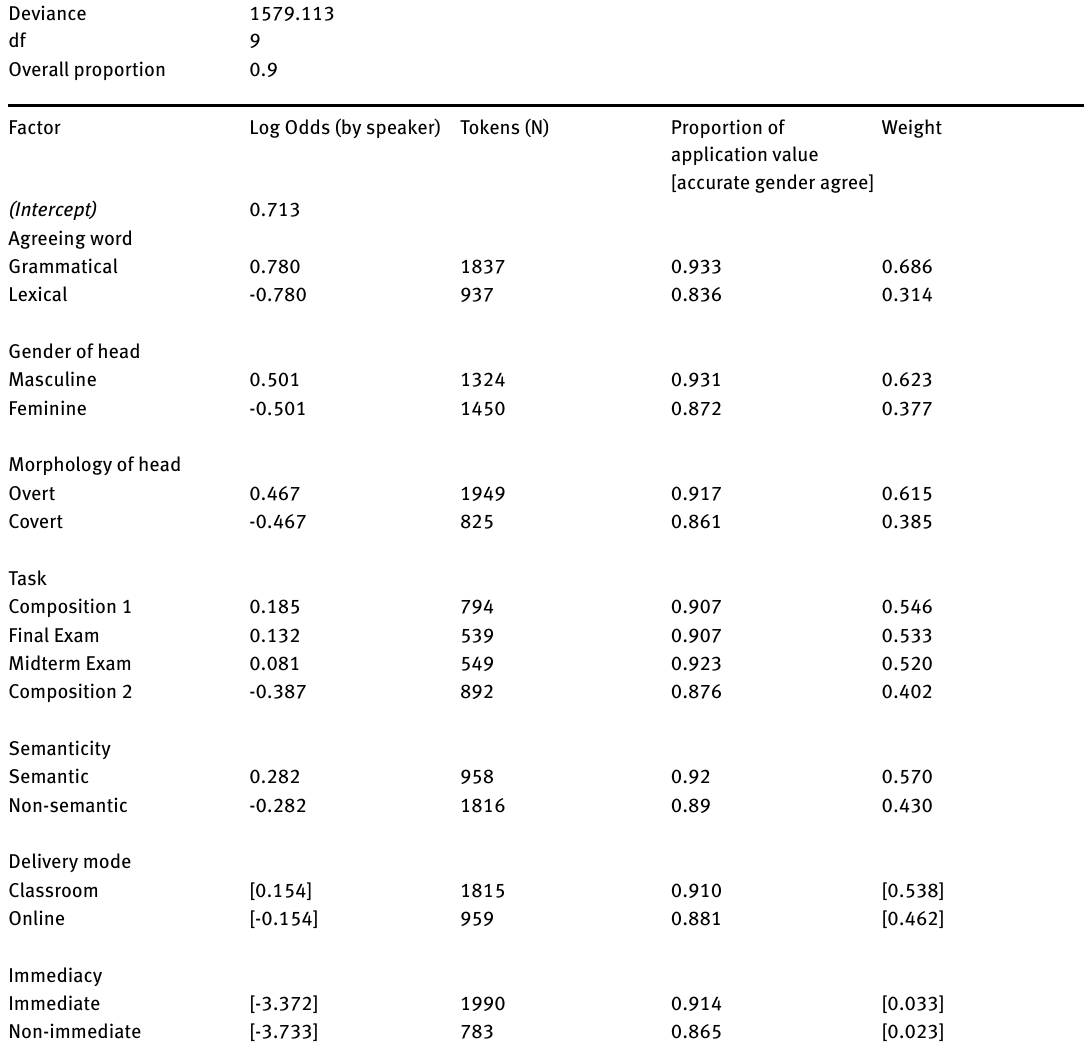
Table 3. Accurate versus inaccurate Spanish gender agreement in all Beginning 1